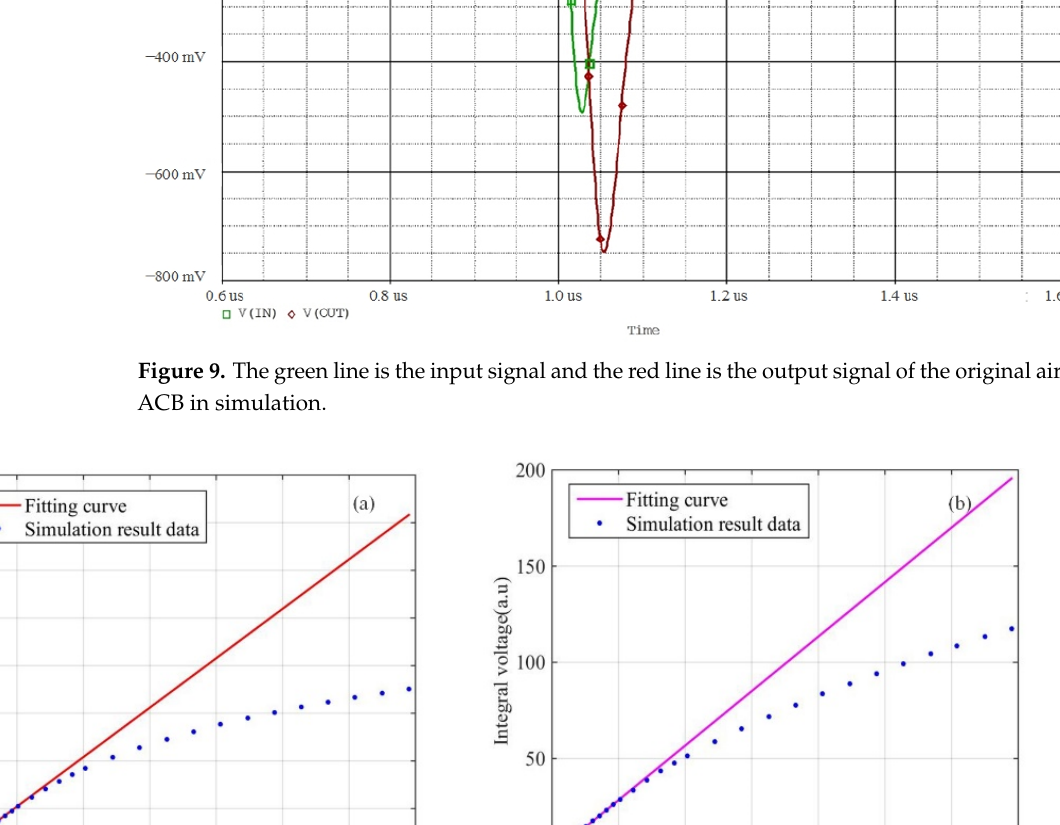
Figure 10. ( a ) The curve of the output peak voltage of the original airborne ACB varying with input power. ( b ) The curve of the output integral voltage of the original airborne ACB varying with input power.